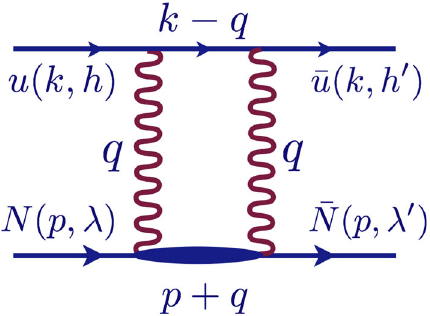
Fig. 1 Two-photon exchange